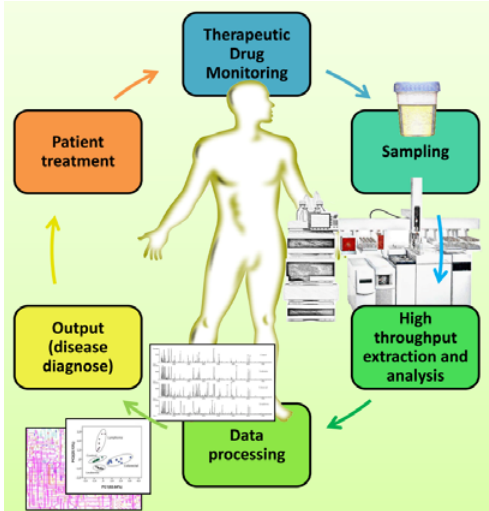
Figure 6. Flowchart for the SPME and MEPS high throughput potential applied to urinalysis for the metabolic profiling of urine and the early diagnosis of high prevalent